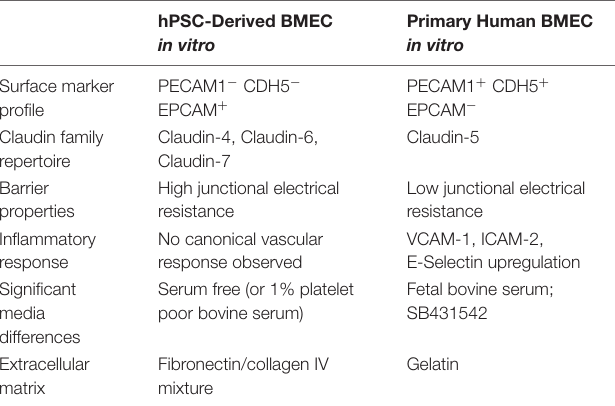
TABLE 2 | hPSC-derived iBMECs are not phenotypically comparable to primary human BMECs. hPSC-Derived BMEC in vitro